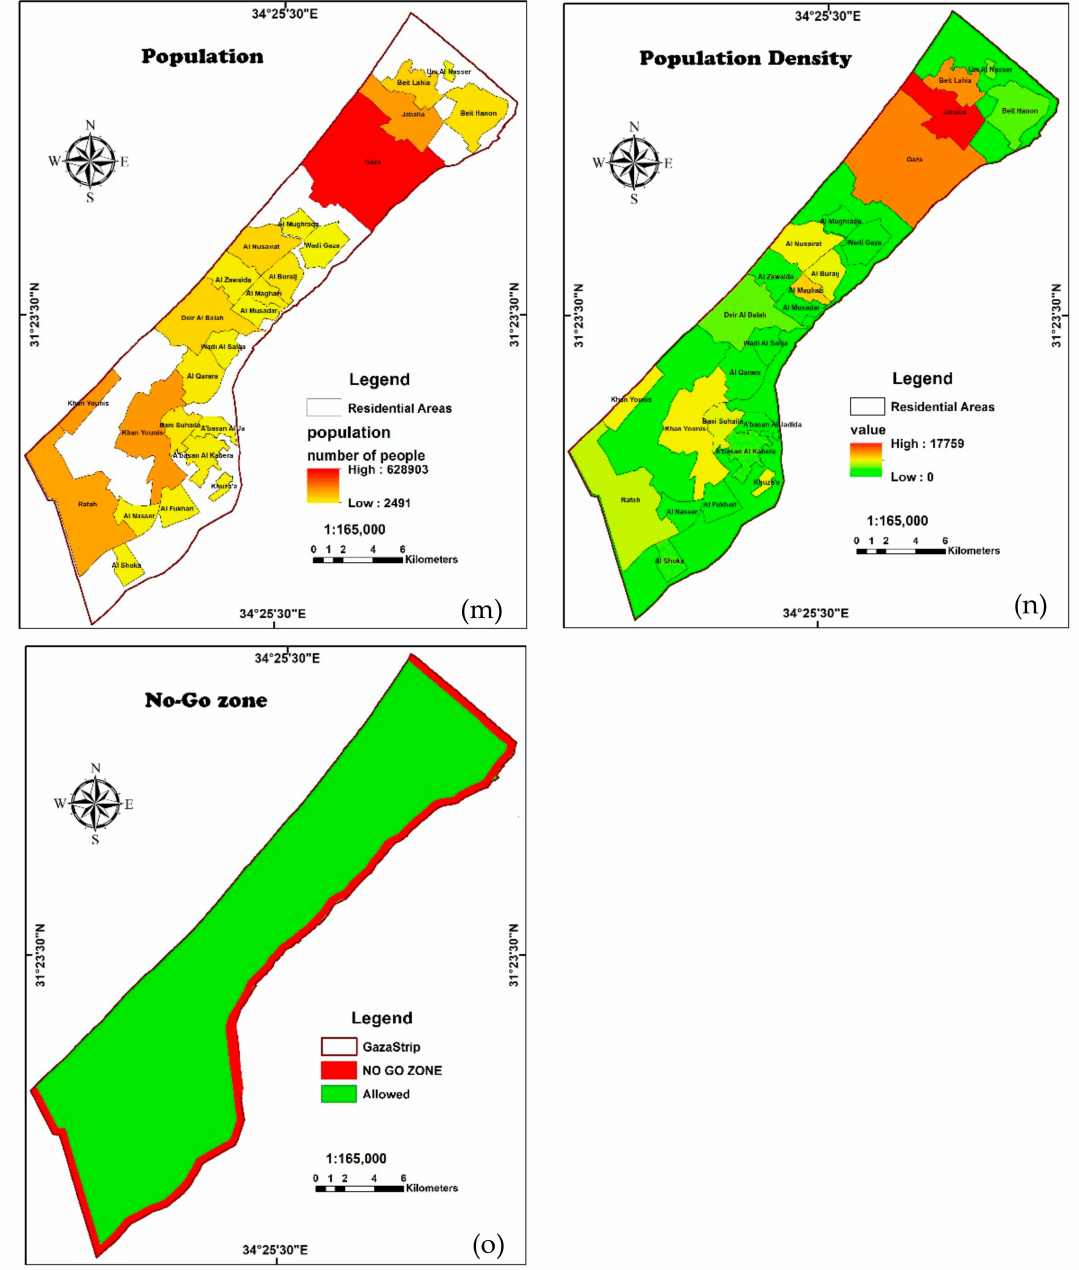
Figure 4. Conditioning factors considered for the hospital site suitability; ( a ) elevation altitude, ( b ) slope surface, ( c ) plan curvature, ( d ) topographic wetness index, ( e ) topographic roughness index, ( f ) stream power index, ( g ) distance from road, ( h ) distance from river, ( i ) distance from main road ( j ) distance from residential, ( k ) distance from agriculture, ( l ) distance from refugee camps ( m ) population size, ( n ) population density, and ( o ) no − go